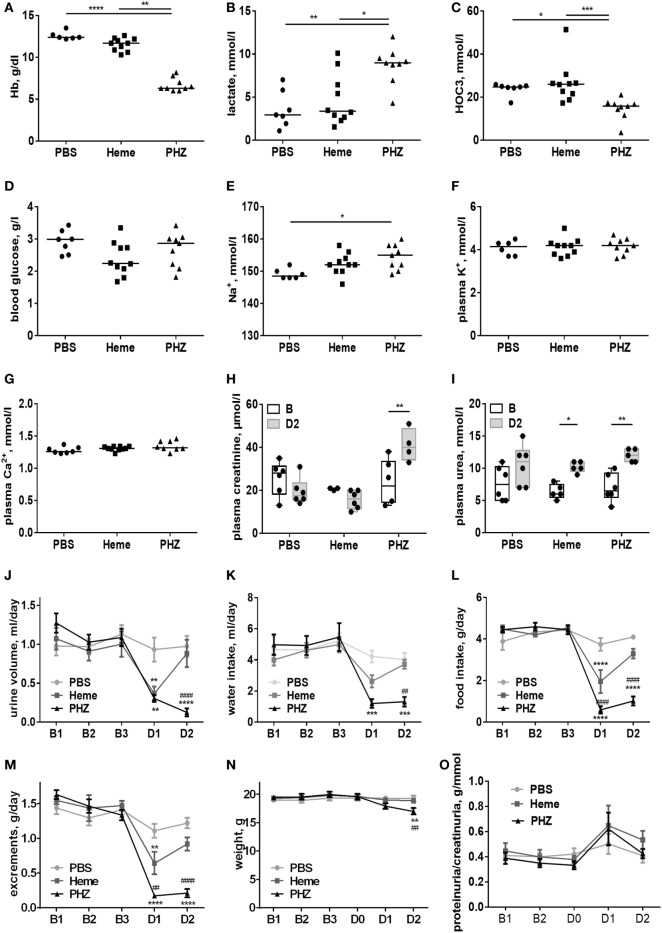
Evaluation of the renal function parameters in the phenylhydrazine (PHZ) and heme-injected mice in metabolic cages. (A) Blood total hemoglobin, (B) plasma lactate, (C) plasma HCO3−, (D) blood glucose, (E) plasma sodium, (F) plasma potassium, (G) plasma calcium, (H) plasma creatinine, and (I) plasma urea. * p < 0.05, ** p < 0.005, *** p < 0.001, and Kruskal–Wallis with Dunn’s test for multiple pairwise comparisons (A–G) or performed by two-way ANOVA with Tukey’s test for multiple pairwise comparisons (H,I). Kinetic evolutions of (J) urine volume, (K) water intake, (L) food intake, (M) excrements, (N) weight, and (O) proteinuria/creatininuria ratio. B1, B2, and B3 correspond to baseline measures three consecutive days before injection, and D1 and D2 correspond to mice follow-up two consecutive days after i.p. injection (for each measure, n ≥ 6 per group). ** p < 0.005, *** p < 0.001, and **** p < 0.0001 compared with PBS-treated mice, ##
p < 0.005 and ####
p < 0.0001 compared with heme-treated mice, and two-way ANOVA with Tukey’s test for multiple pairwise comparisons.